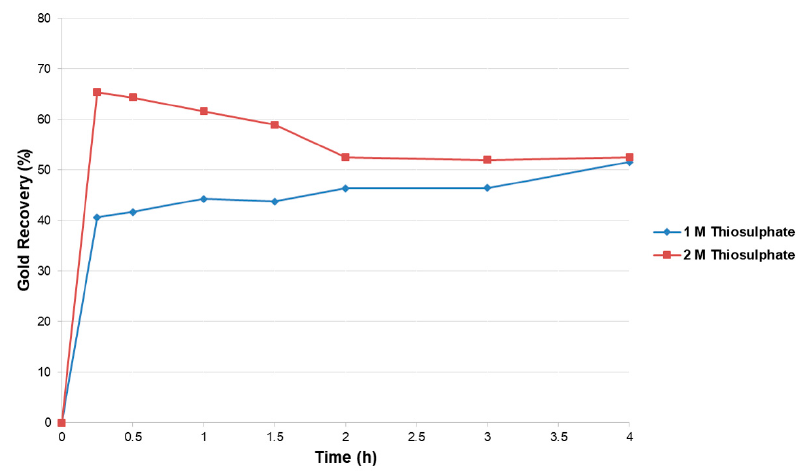
Figure 3. The influence of S 2 O 32 − concentration on gold recovery (4 M NH 3 ; 0.1 M CuSO 4 ).